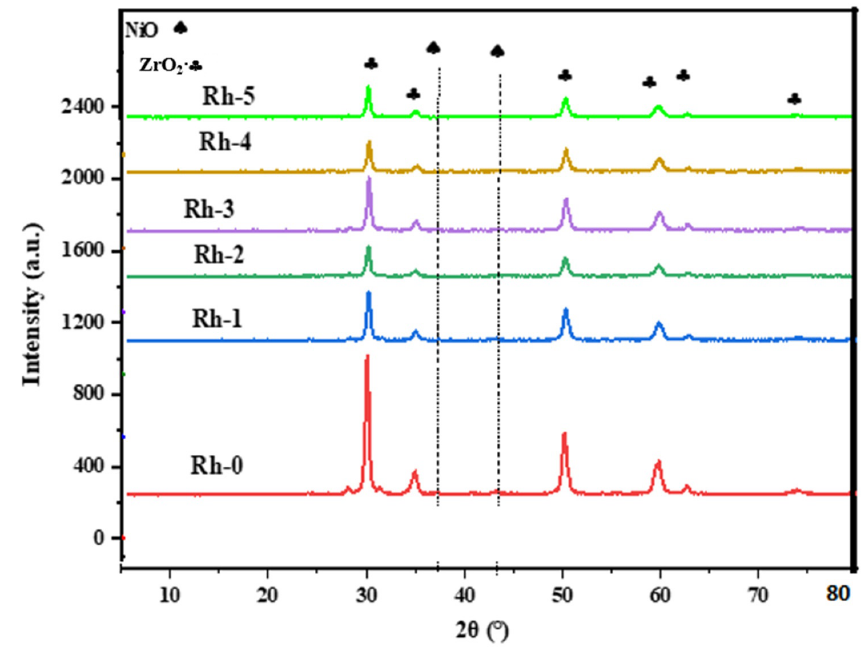
Figure 2. XRD pattern of fresh Rh-x (x = 0, 1, 2, 3, 4, and 5 wt.%) catalyst samples. ( ♠ ) NiO and ( ♣ ) cubic phases of yttria-stabilized zirconia samples. To perform H 2 -temperature programming reduction (H 2 -TPR) analysis, a sample of ca. 100 mg of catalyst was placed in a r micro-reactor (i.d., 4 mm), fed with a 5 vol. % H 2 /Ar at a flow rate of 3.6 L/h at STP, in the range of 0–700 °C, with a heating rate of 12 °C/min. A thermal conductivity detector (TCD) monitored the hydrogen consumption. Figure 3 displays the TPR profiles of the fresh Rh-x (x = 0, 1, 2, 3, 4, and 5 wt.%) catalysts. The reduction peaks for the Rh-promoted Ni catalysts appeared in the low temperature range (80–250 ° C). These were attributed to Ni catalysts loosely attached to the support, while the broad peaks with overlapped shoulders in the medium temperature range (300–500 ° C) was for the unpromoted Ni catalysts, whereby the Ni was moderately attached to the support. The incorporation of the Rh-promoter caused the reduction peaks for nickel ox- ide to shift to lower temperatures in the range of 250-350 ° C; the higher the loading of Rh was, the lower the reduction temperature was, viz. the weaker the interaction between the nickel oxide and the support was. Moreover, all the catalysts did not show any apprecia- ble peak beyond 550 ° C, stipulating that all the existing oxides were reduced and the ab- sence of spinel phases like NiRh 2 O 3 . The incorporation of Rh 2 O 3 (1–3 wt.%) slightly boosted the rate of H 2 consumption, as shown in Table 2. Further increase in Rh 2 O 3 loading (3–5 wt.%) did not affect the amount of hydrogen consumption, indicating that Rh 2 O 3 was impeded under the surface of the catalysts.